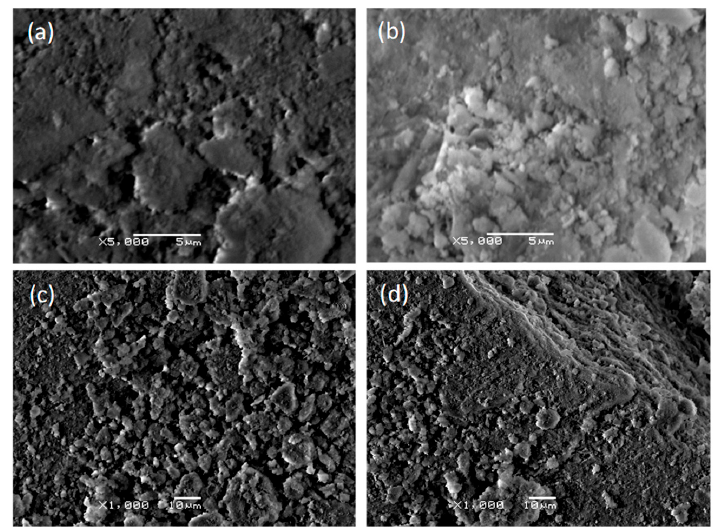
Figure 4. SEM images of ( a ) HA, ( b ) Zn–HA, ( c ) Mg–HA and ( d ) Si–HA showing the covering of substrate with deposited particles. Particles are in the micron range.